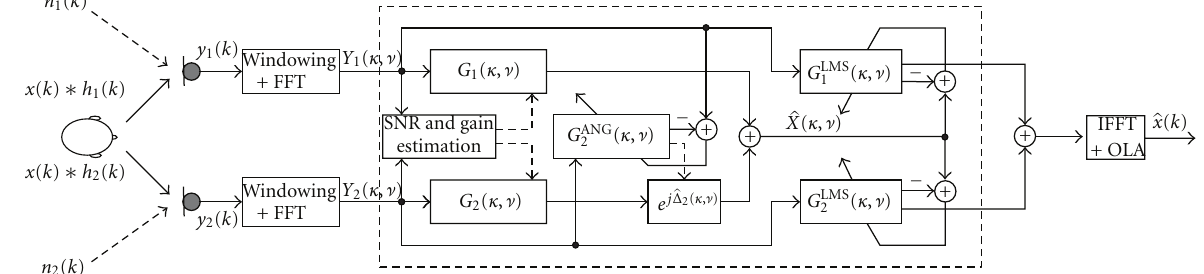
Figure 9: Comparison of the system transfer functions.